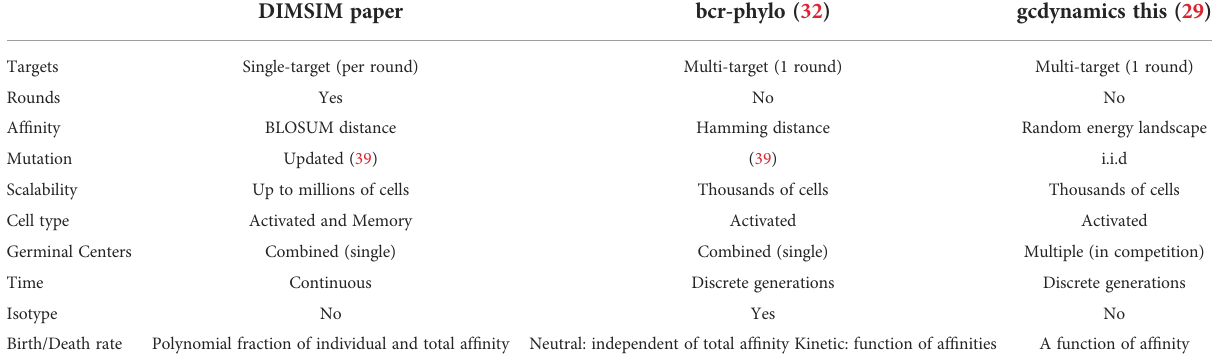
TABLE 5 A comparison of Most relevant tools for AM